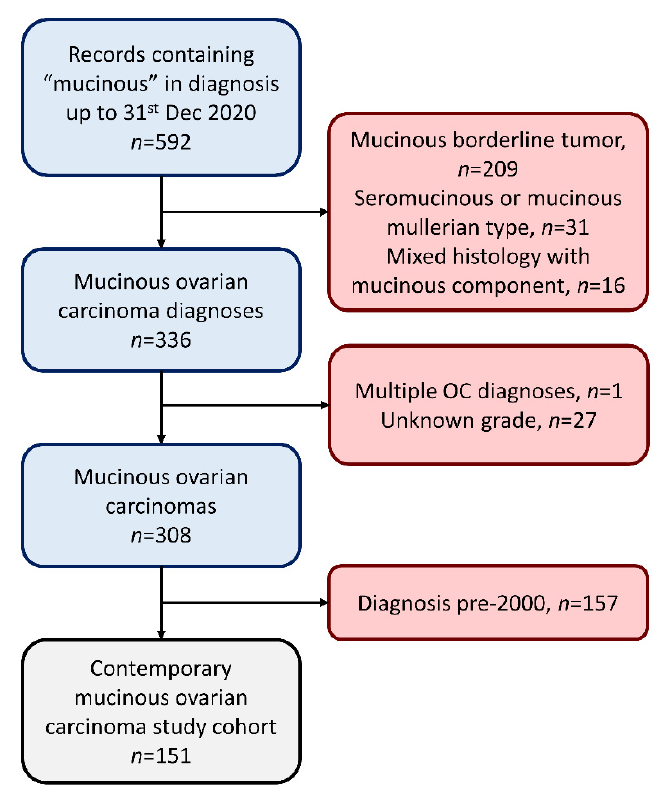
Figure 1. Identification of mucinous ovarian carcinoma patient cohort.